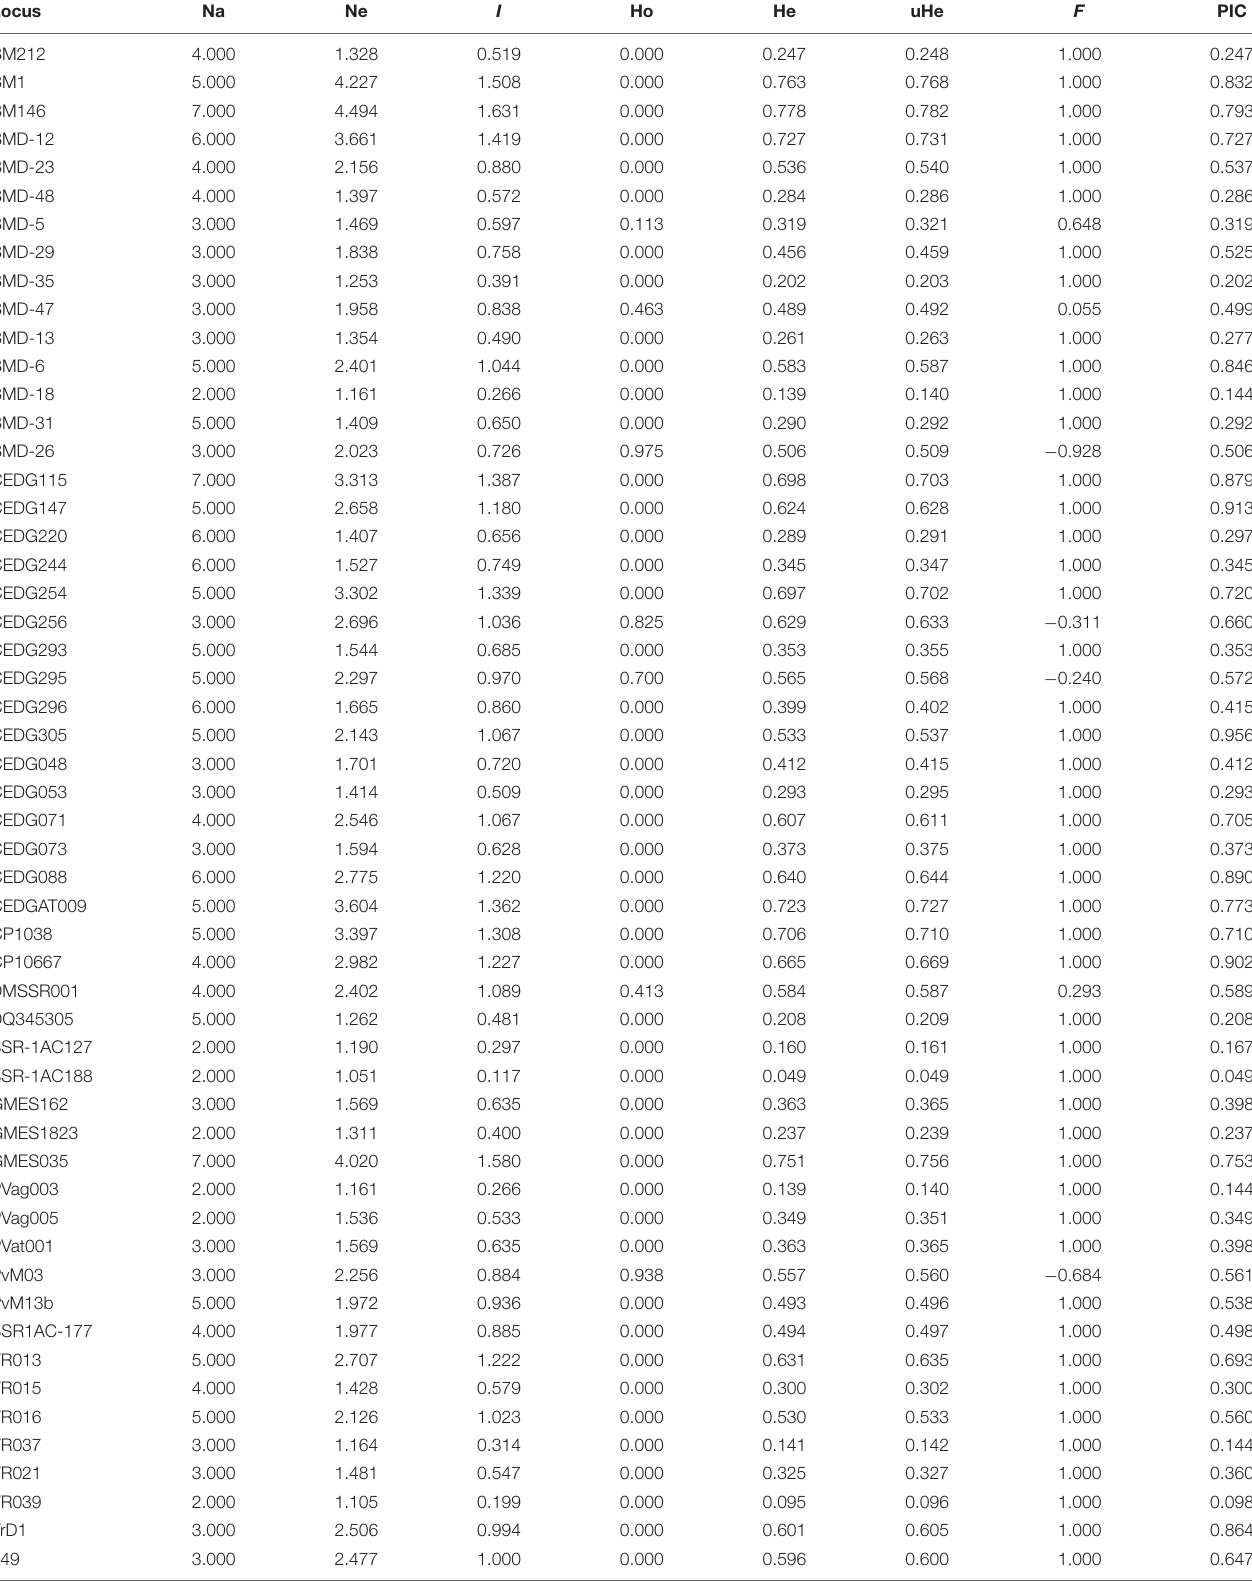
TABLE 2 | Details of polymorphic markers along with their allelic diversity and PIC.